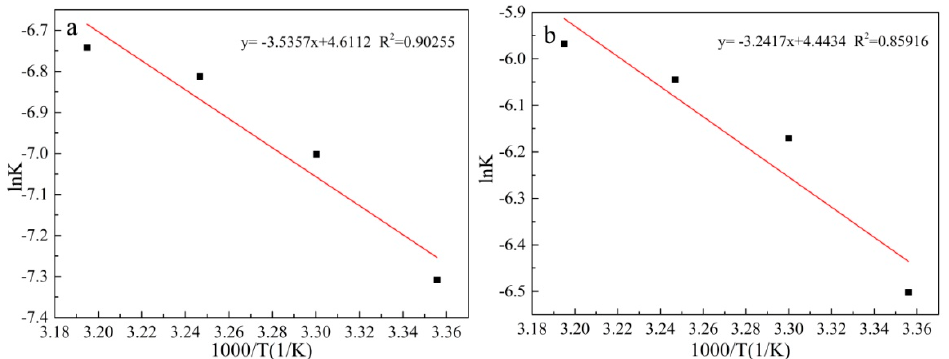
Figure 21. Arrhenius curve obtained for 1/3ln(1 − x) − 1 − (1 − x) − 1/3 model under conventional and ultrasonic conditions. ( a ): under conventional conditions; ( b ): under ultrasonic conditions.